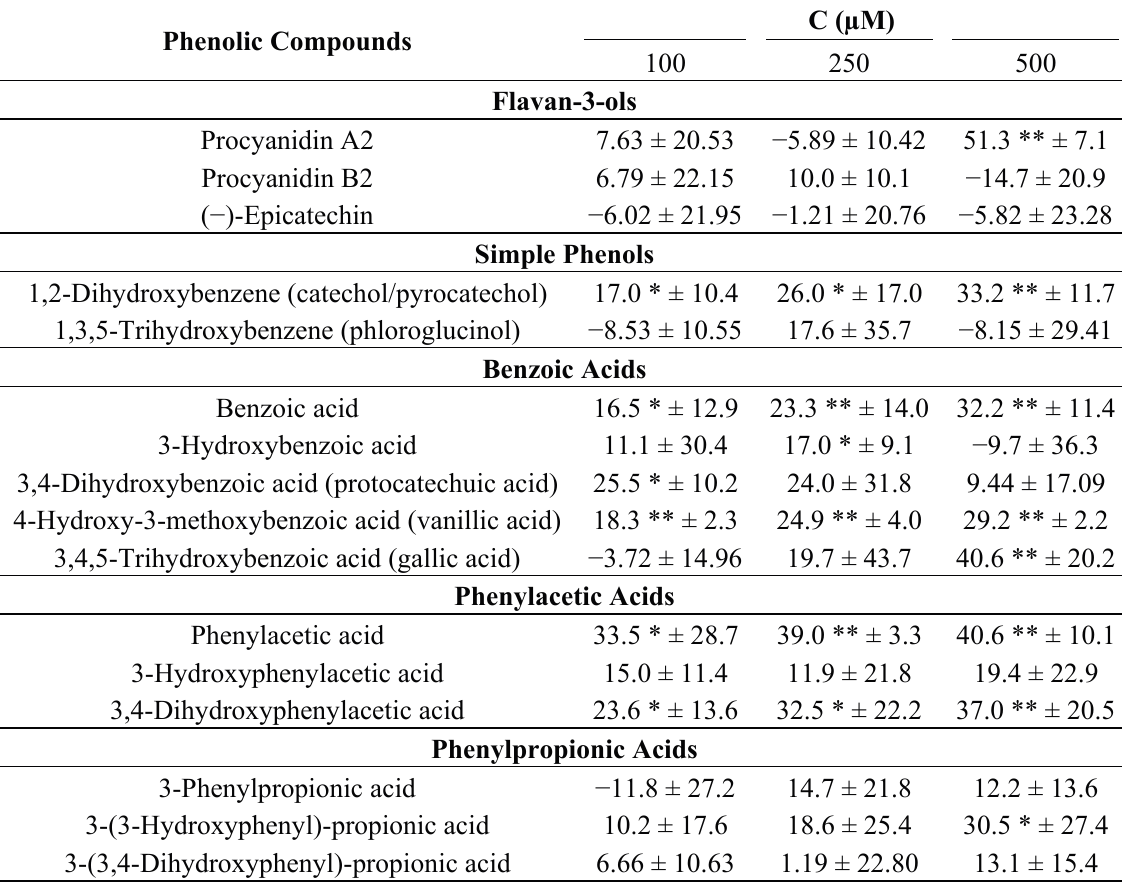
Table 1. Inhibition (%) of the adherence of E. coli ATCC ® 53503™ to ATCC ® HTB4™ cells by phenolic